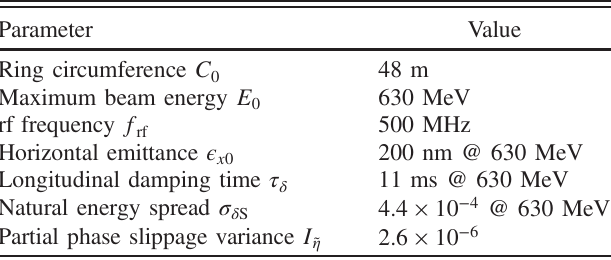
TABLE I. Parameters of the MLS low-alpha user lattice.